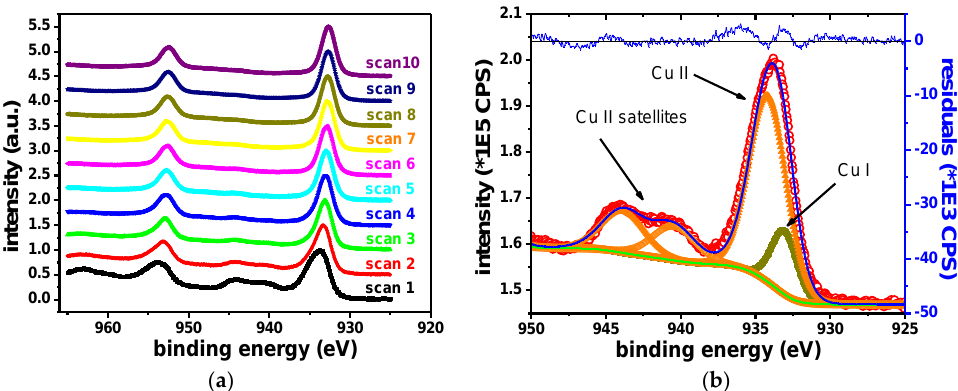
Figure 9. Copper sample degradation ( a ) and fit of the initial narrow scan ( b ). Table 8. Cu2p 3/2 fit parameters (referenced to adventitious carbon C1s peak at 285.1 eV).